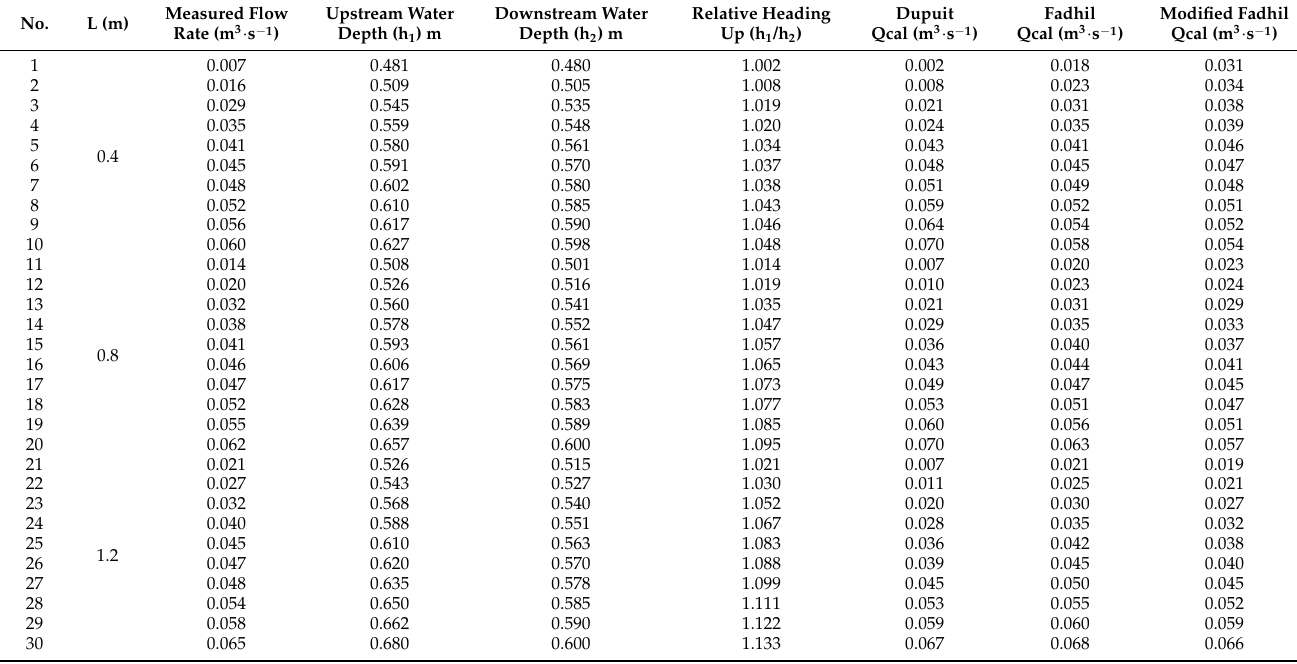
Table 2. The measured flow rate, water depths upstream and downstream of the biofilter, the resulting relative heading up (h 1 /h 2 ), and the flow rate calculated from the Dupuit formula, Fadhil equation, and modified Fadhil’s equation. No. L